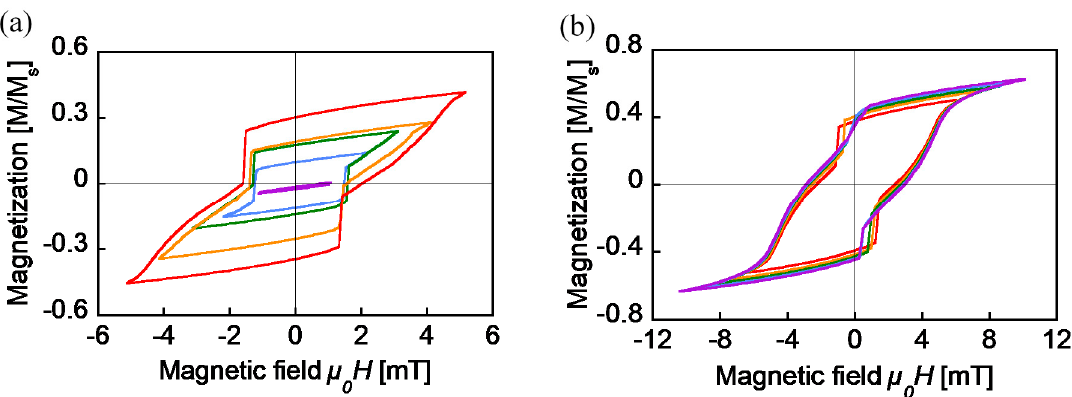
Figure 4. DC minor loops of the FeCoV wire (0.25 mm diameter and 11 mm length). The applied field intensities are ( a ) μ 0 H = 1–5 mT and ( b ) μ 0 H = 6–10 mT.